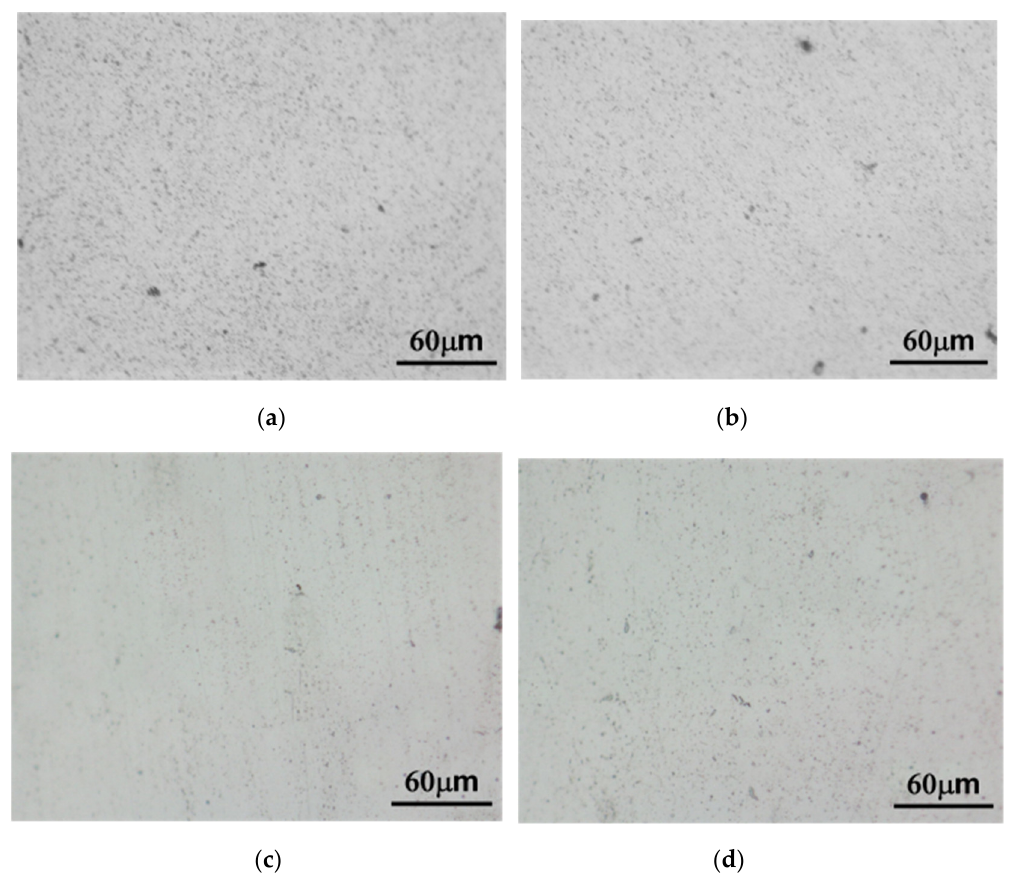
Figure 6. Optical photomicrographs of ( a ) alloy A , ( b ) alloy B , ( c ) alloy C and ( d ) alloy D after homogenization treatment.